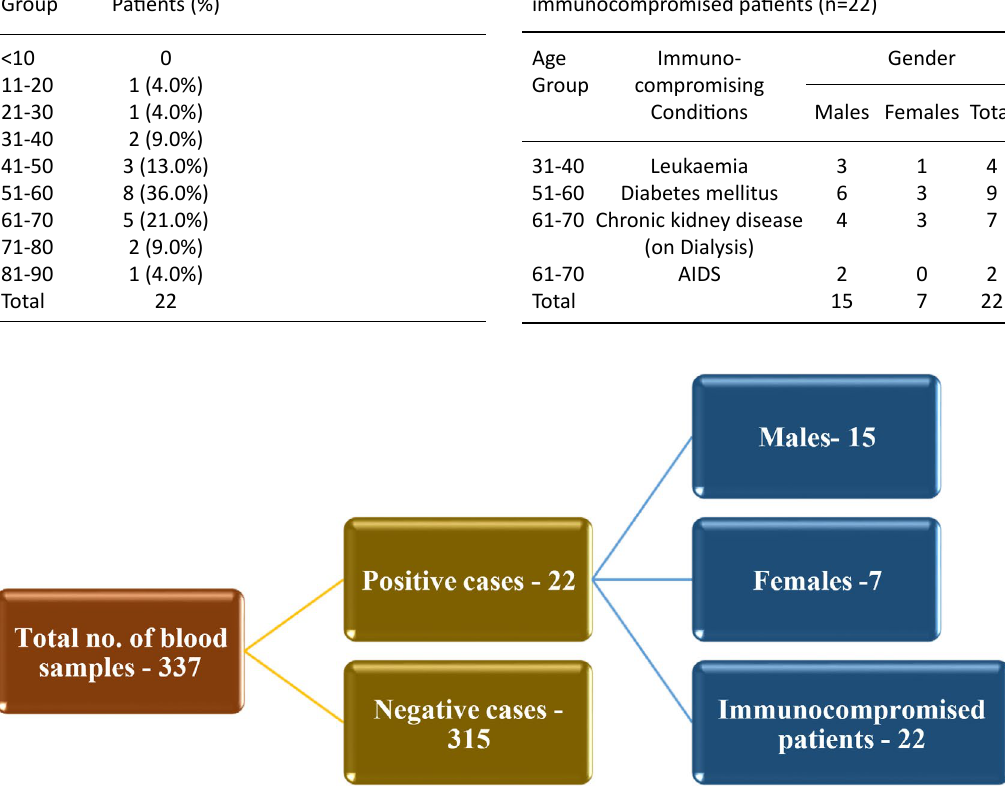
Fig. 1. Distribution of positive cases in the study